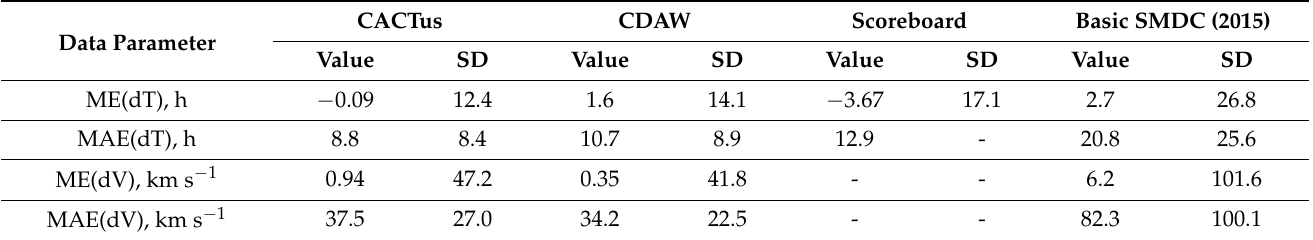
Table 7. Prediction errors ME, MAE and SD for the tested ICME set obtained with the ensemble SMDC using the CACtus and CDAW data and γ opt = 0.3 × 10 − 7 km − 1 in comparison with the “Average of all methods” Scoreboard data (see Table 3 from [65]) and with basic SMDC.